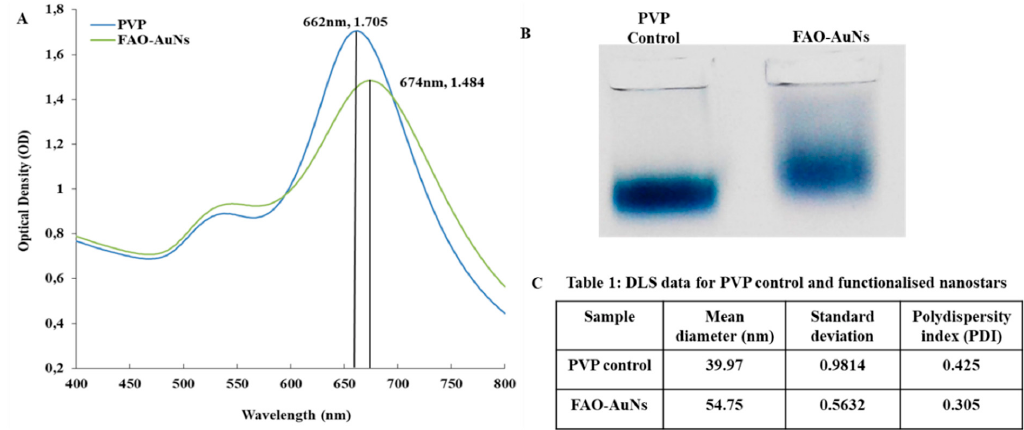
Figure 3. Confirmation of FAO-AuNs functionalisation. ( A ) UV-Vis spectra, ( B ) agarose gel electrophoresis and ( C ) DLS results of functionalised and unfunctionalised nanostars.